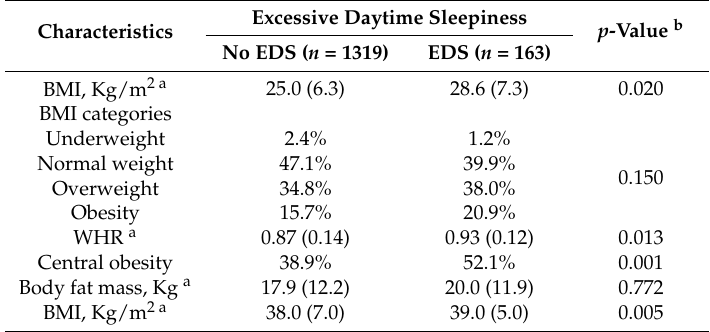
Table 4. Anthropometric measures and indices of obesity by excessive daytime sleepiness.